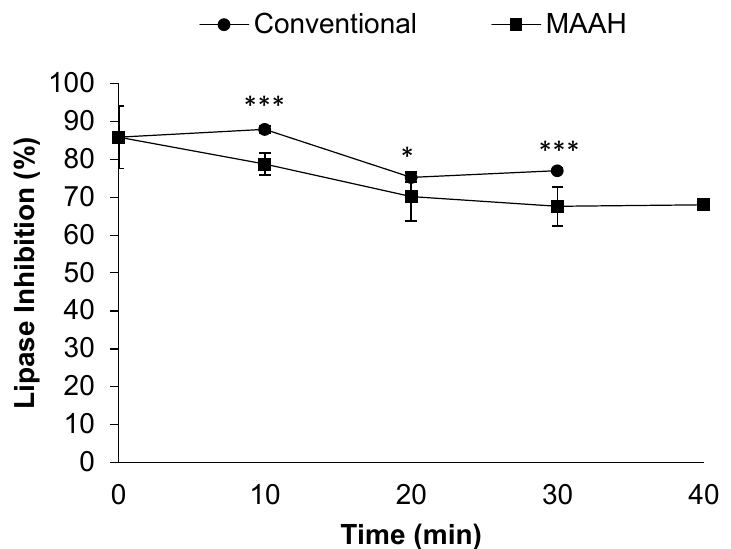
Figure 6. Effect of time on the pancreatic lipase inhibition (%) of fenugreek extracts and sapogenin- rich extracts obtained by conventional hydrolysis and microwave-assisted acid hydrolysis (MAAH). Standard deviations are indicated by error bars. Mean values at the same time of hydrolysis are significantly different if p ≤ 0.05 (*) and p ≤ 0.001 (***).